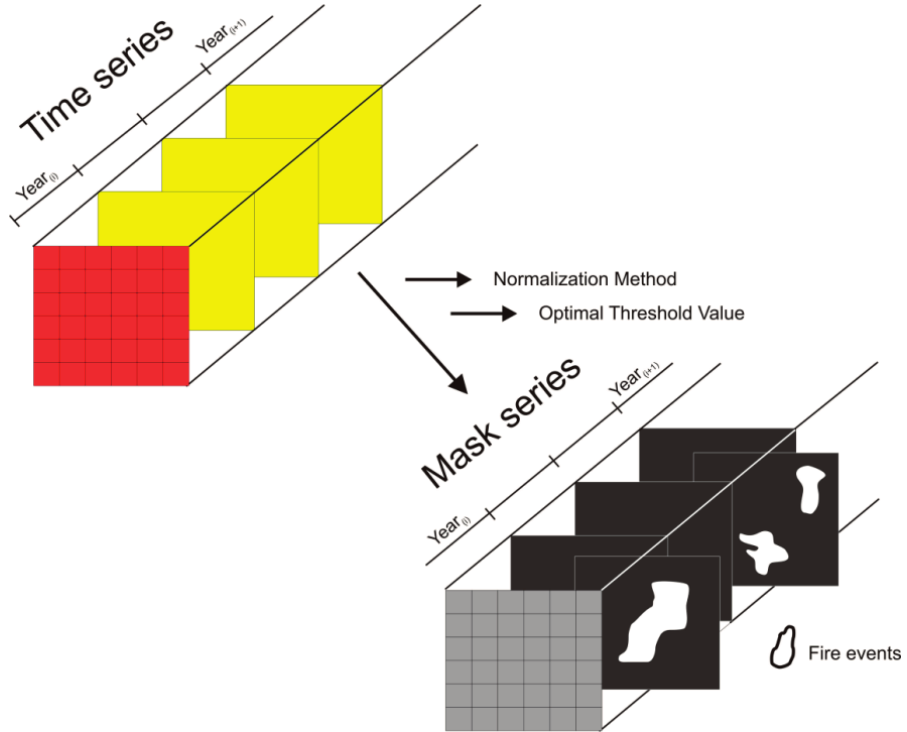
Figure 10. Mask series of the fire events detected in the time